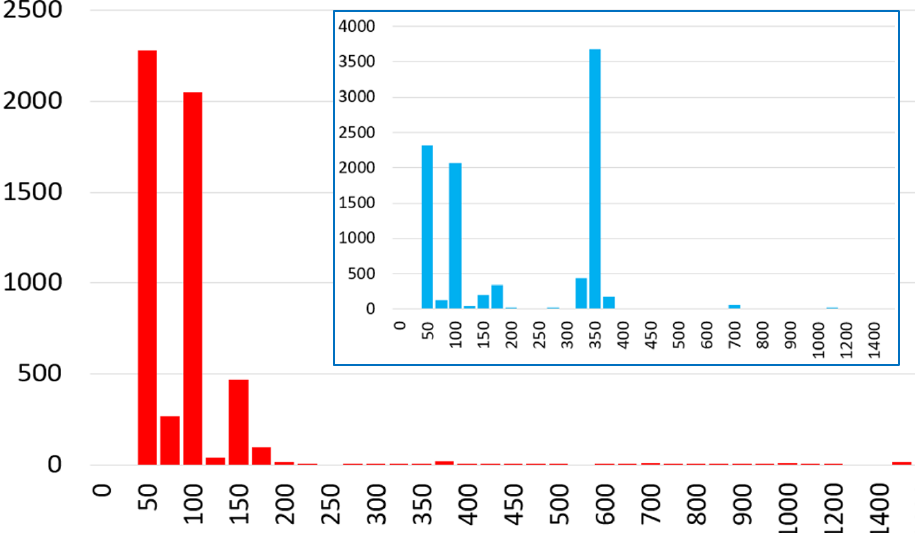
Figure 13. Downlink (red) and uplink (blue) traffic packet size distribution of APN “B” (x axis: number of packets, y axis: Size of flows [Byte]).